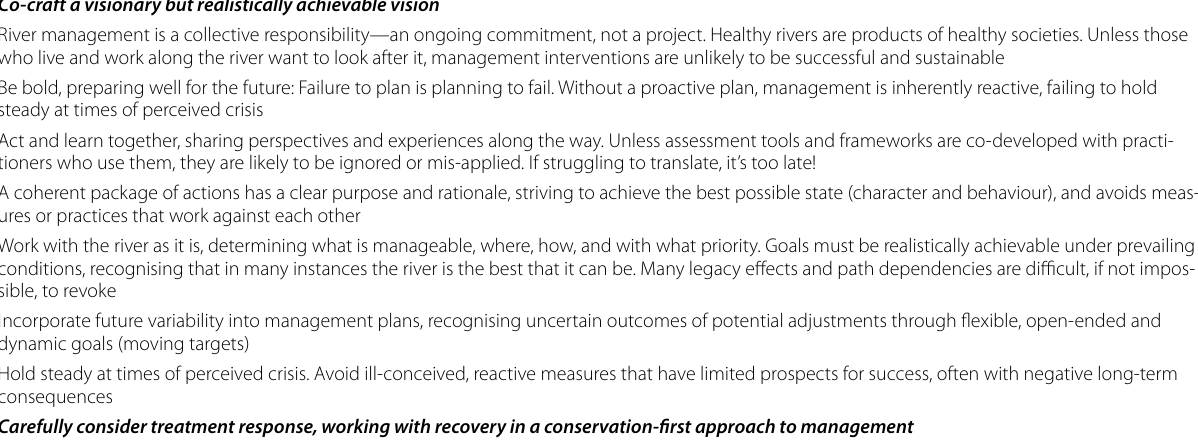
Table 7 Guiding principles for proactive and precautionary catchment plans that heed lessons learnt from the Truths of the